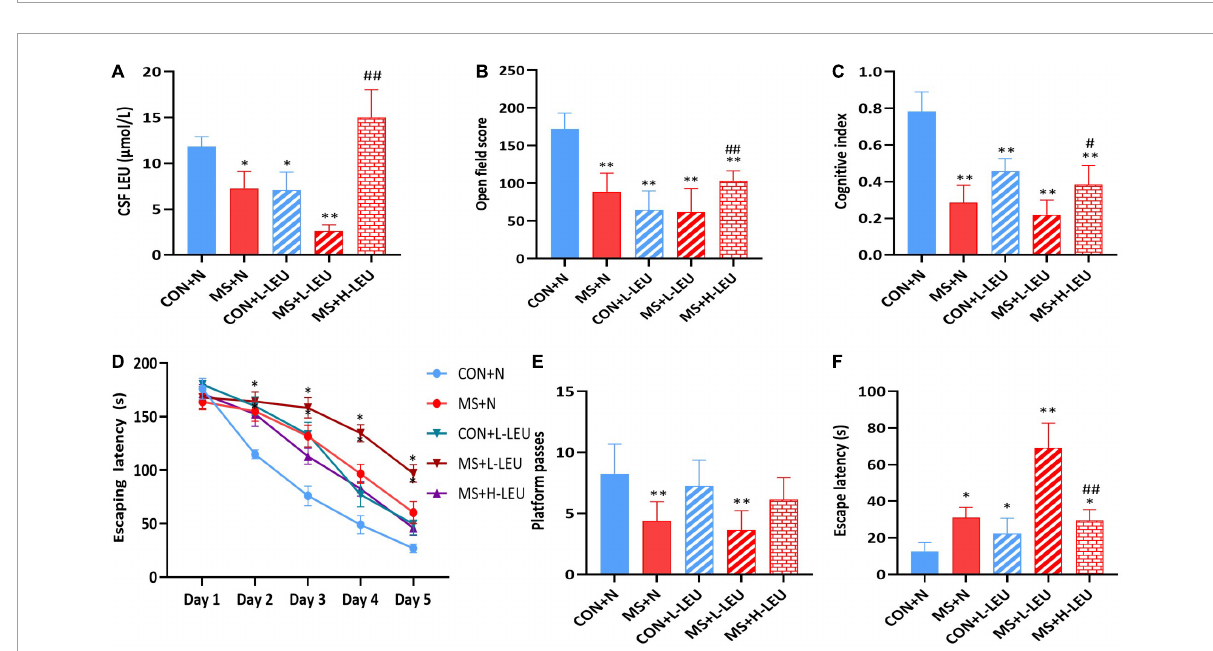
FIGURE3 Effect of dietary leucine content on cognitive function in rats. (A) Leucine content in cerebrospinal fluid. (B) Open field score. (C) Cognitive index. (D) Escape latency of Morris water maze during learning time. (E) Platform passes of Morris water maze. (F) Escape latency of Morris water maze. * p < 0.05, ∗∗ p < 0.01 vs. CON + N, # p < 0.05, ## p < 0.01 vs. MS + L-LEU vs. control, n =